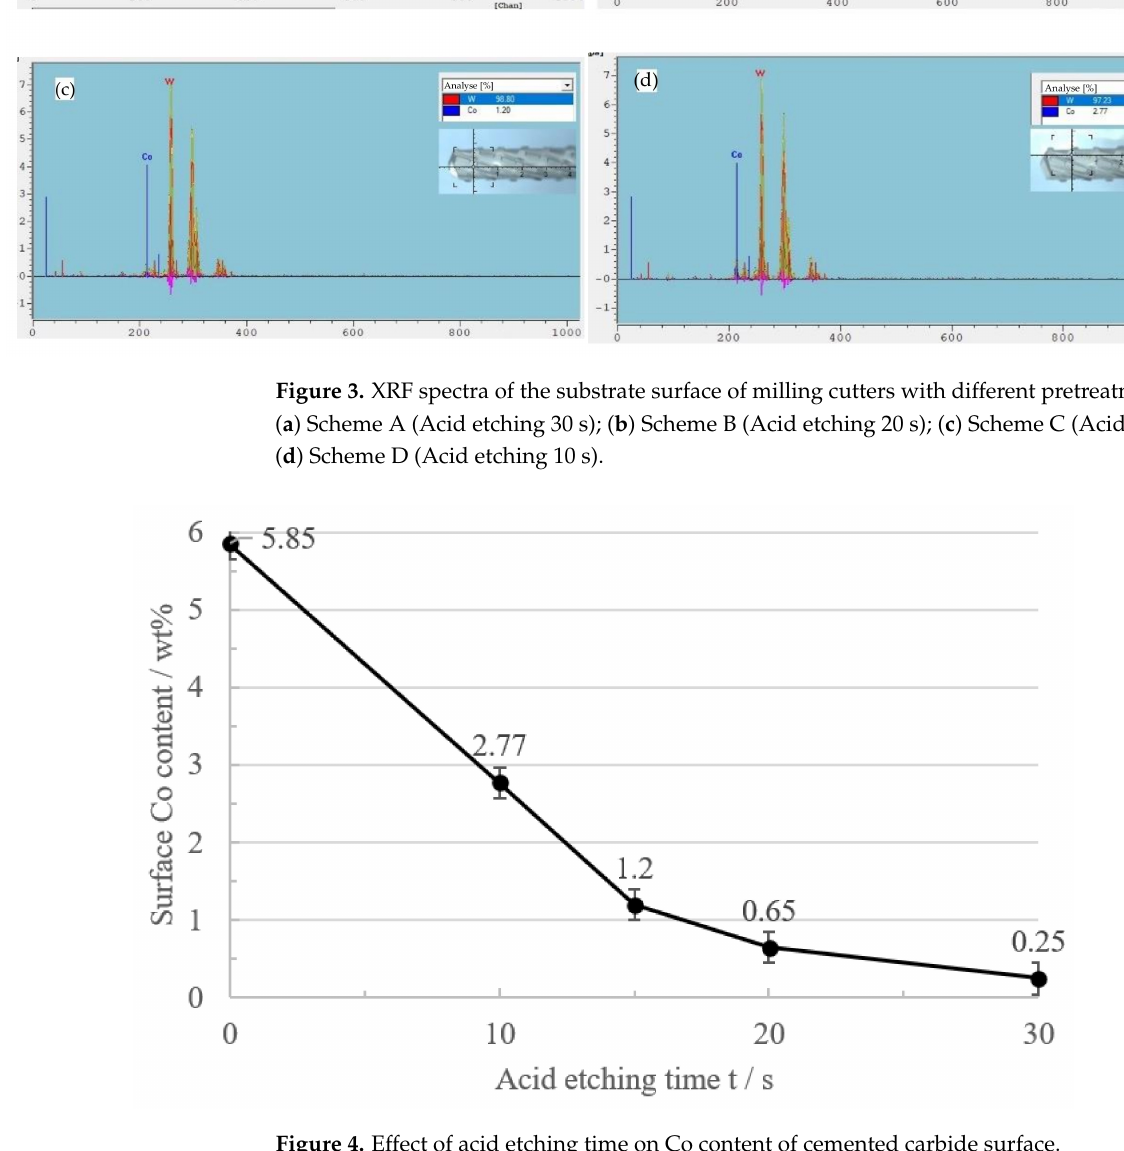
Figure 4. Effect of acid etching time on Co content of cemented carbide surface. v m is the Raman shift of the SP 3 carbon structure peak measured by Raman spec- troscopy, and v 0 is the Raman shift of the unstressed diamond (1332.5 cm − 1 ). The residual stresses of the diamond coatings were calculated to be − 2.89 GPa and − 2.09 GPa for the four pretreatment schemes, indicating the existence of a certain compressive stress inside the coatings, which is beneficial to improving the fracture strength of the